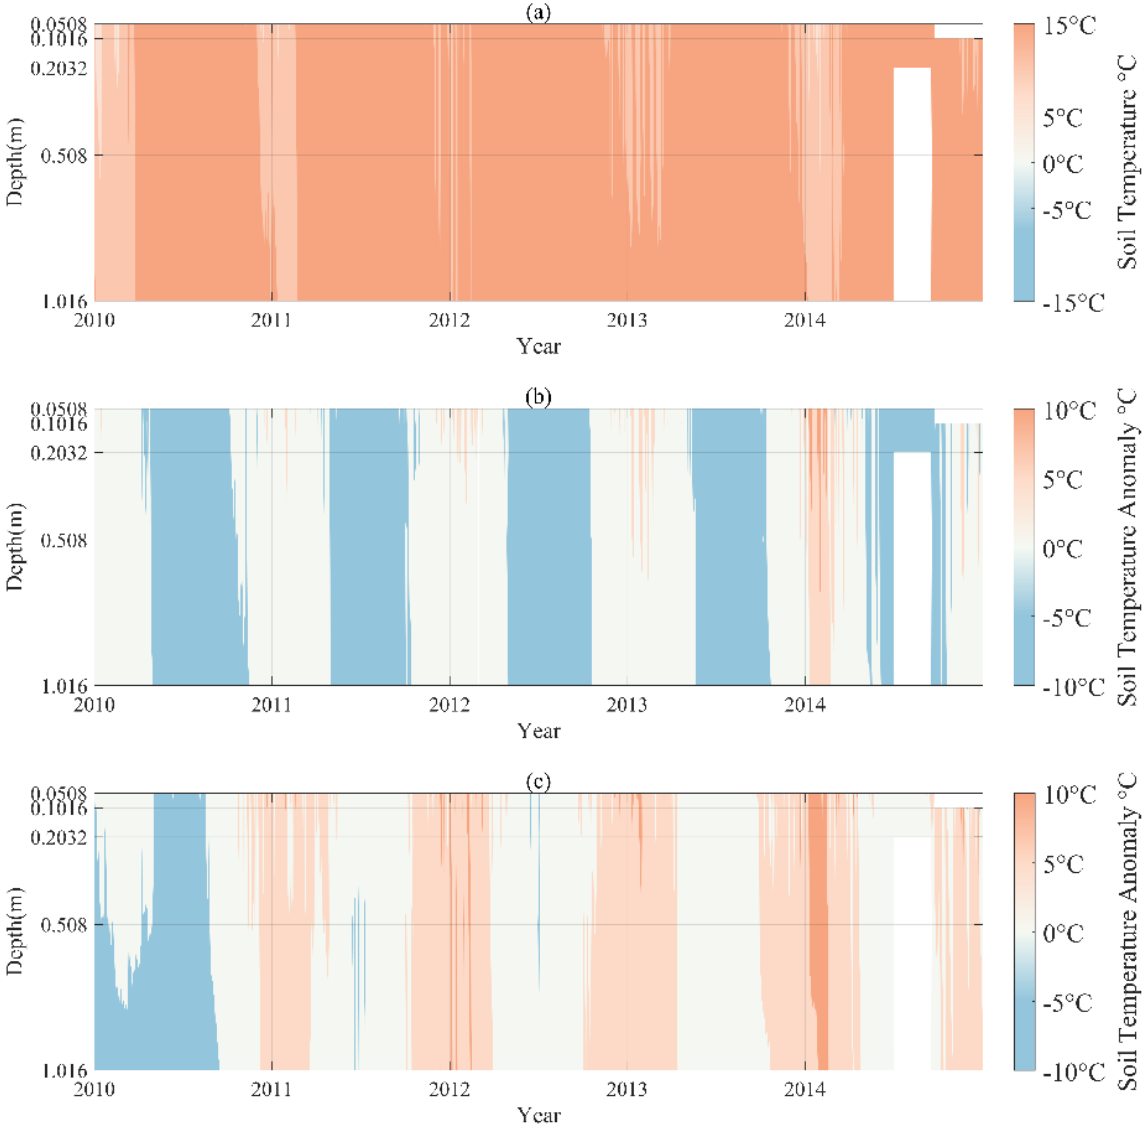
Figure 14. Soil temperature vertical profiles at Tnc Fort Bayou from 2010 to 2014: ( a ) observations, ( b ) the difference between CLM5’s simulation and the observations, and ( c ) difference between CoLM2014’s simulation and the observations.